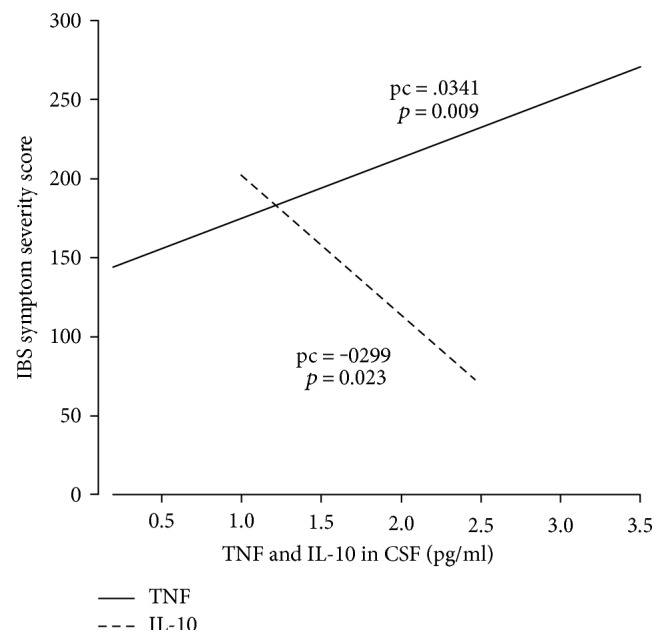
The figure shows the associations between TNF and IL-10 in the cerebrospinal fluid (CSF) and perceived symptom severity (IBS symptom severity score) measured at the average of the other covariates.